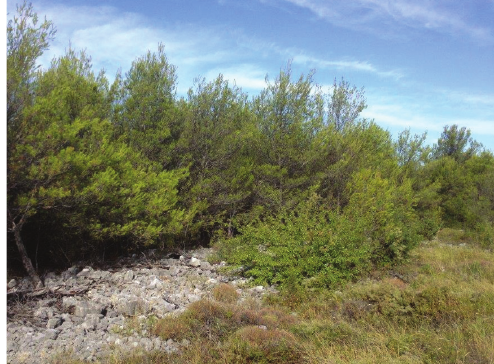
figUre 3. Recovered Aleppo pine stand after Dendrolimus pini defoliation and Beauveria bassiana infestation on overwintering larvae in 2015 in Skradin, Šibenik.